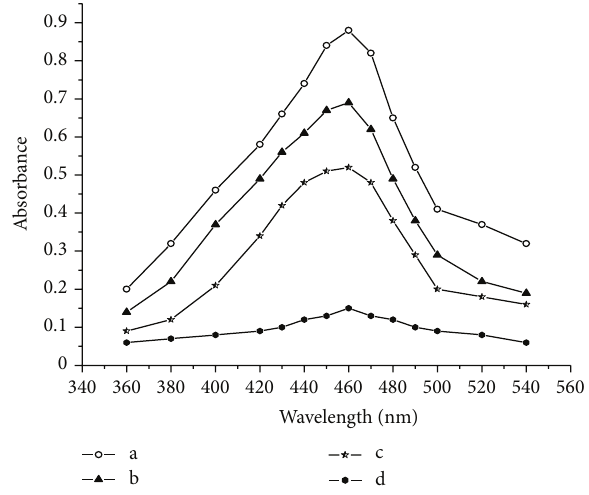
Figure 2: Absorption spectra, method B, (a, b, c, and d are absorption spectra of blank, 2, 4, and 8, 20 𝜇 gmL −1 KTF, resp.).